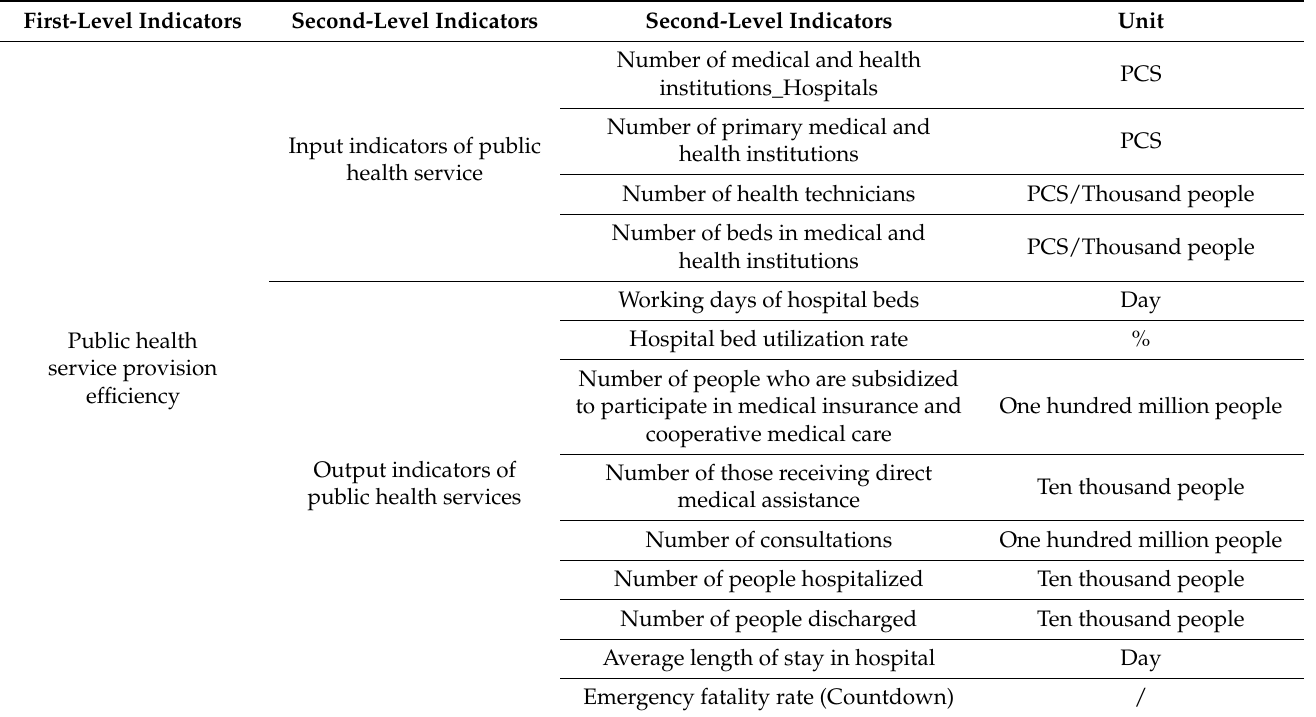
Table 2. Input and output indicators of public health provision efficiency